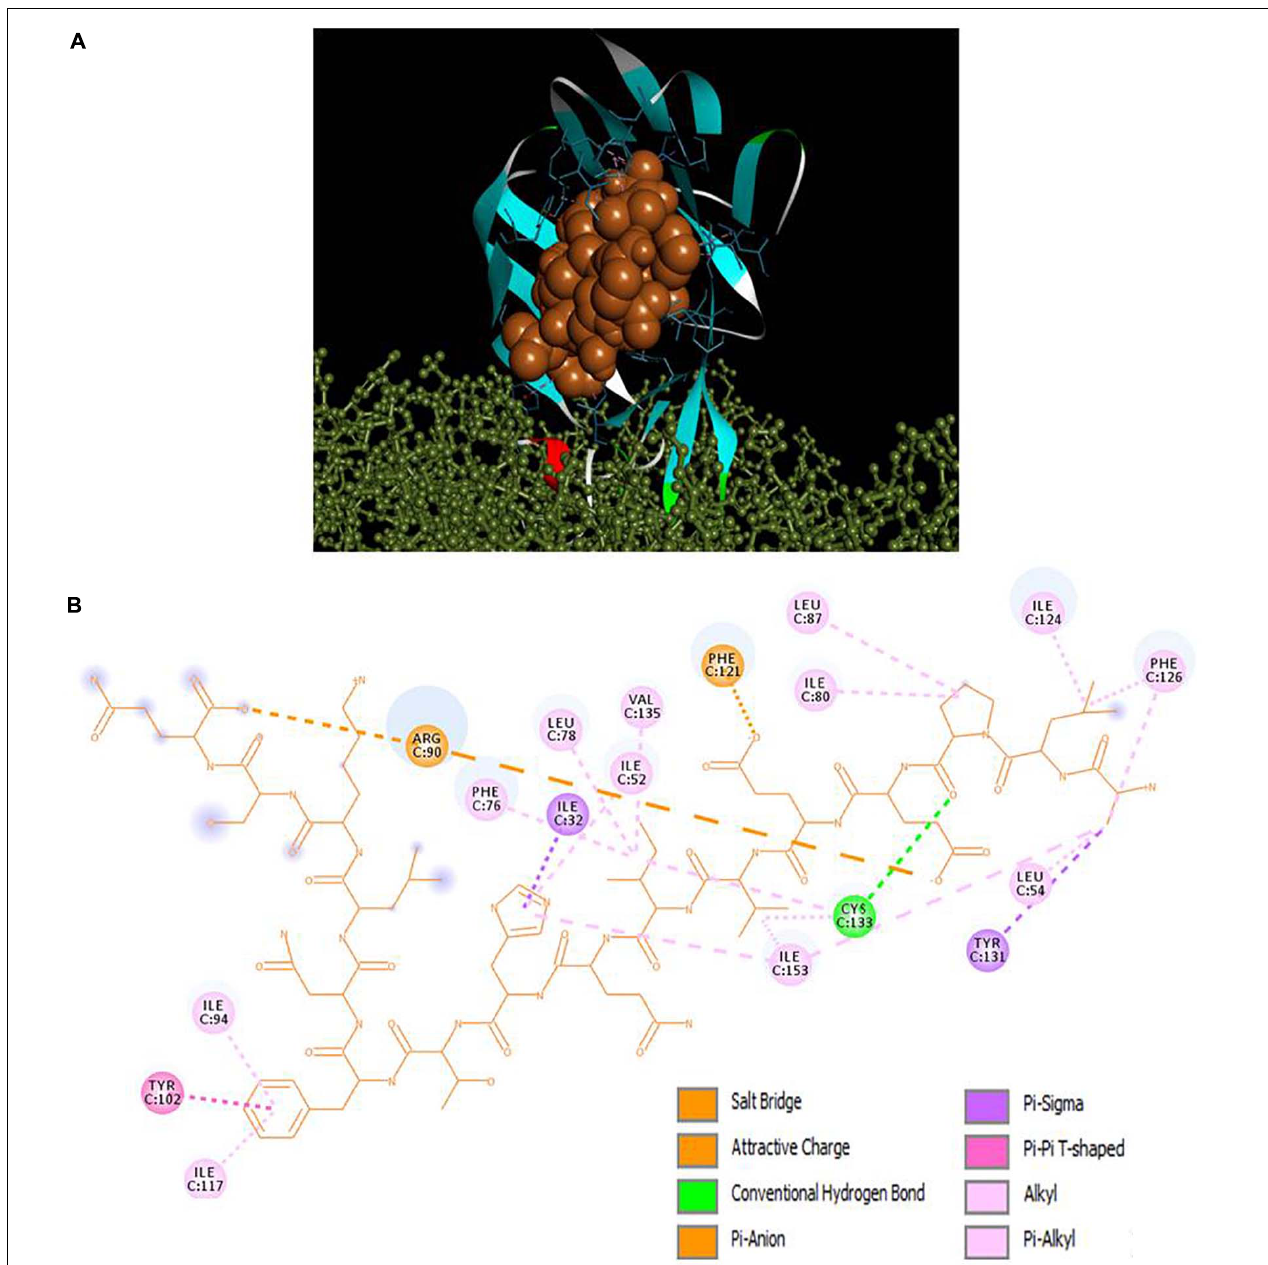
FIGURE 4 | (A) Docking of TLR4 (ball and stick)/MD2 (ribbon) complex with peptide P13 (CPK), (B) 2D representation of TLR4/MD2-peptide interactions. ARG90, TYR102, PHE126, and CYS133 are designated as critical to TLR4/MD2-LPS binding.